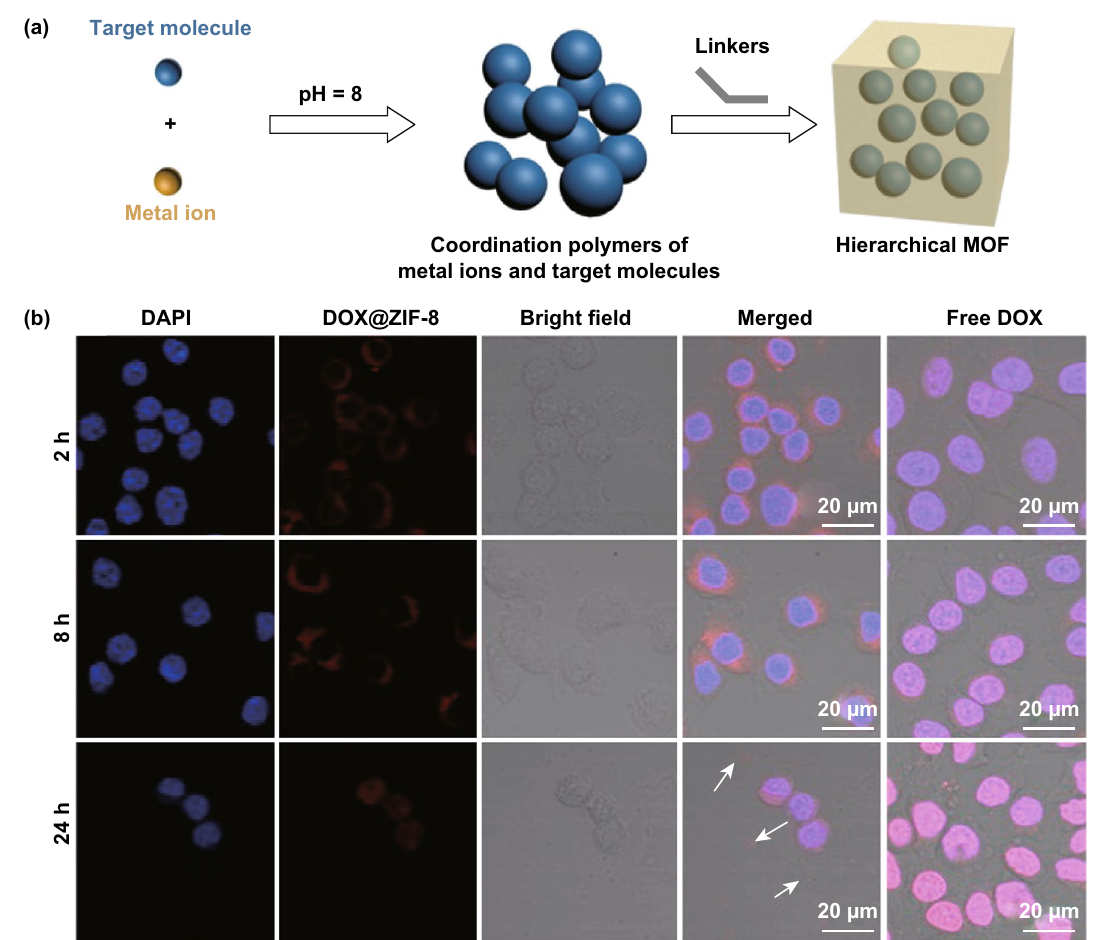
Fig. 6 a pH-induced one-pot synthesis of hierarchical ZIF-8 with encapsulated drug molecules. b Cell uptake studies conducted to compare the localizations of DOX@ZIF-8 and free DOX in the MDA-MB-468 cells. Reproduced with permission from Ref. [103]. Copyright 2015, Ameri- can Chemical